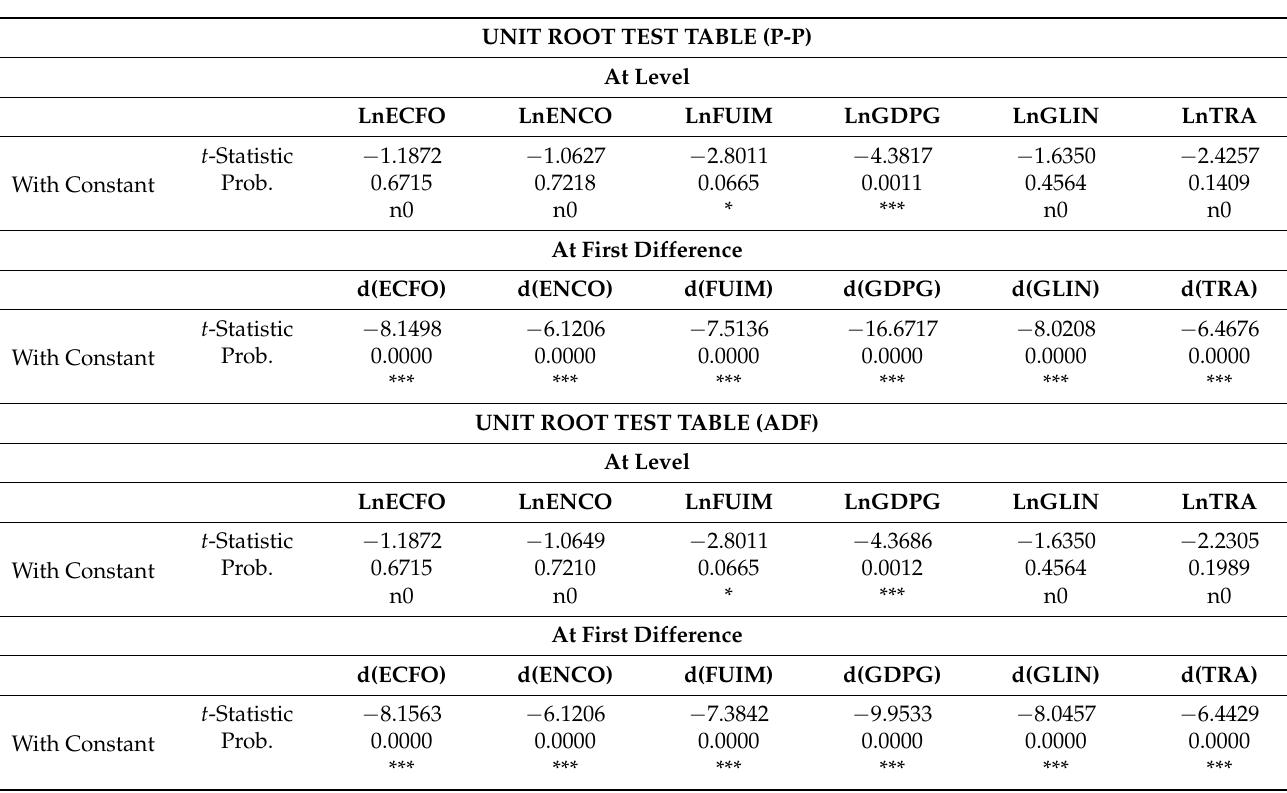
Table 2. Unit root tests.